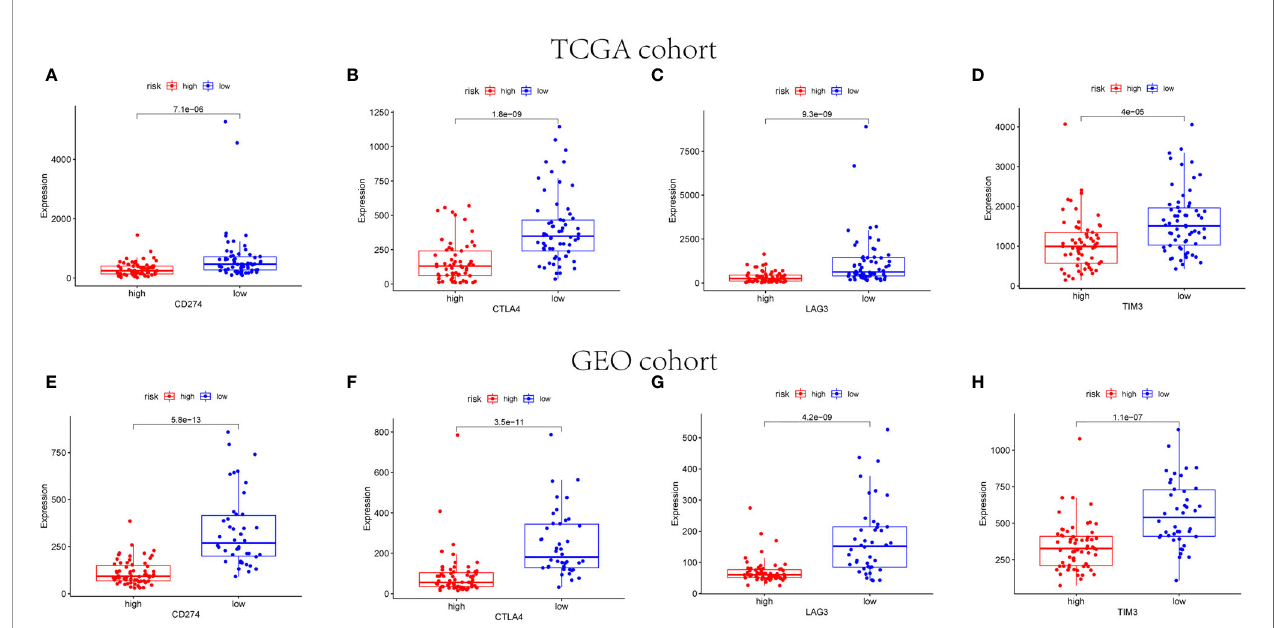
FIGURE 12 | Immune checkpoint gene expression levels in high- and low-risk groups. The expression levels of CD274 (A) , CTLA4 (B) , LAG3 (C) , and TIM3 (D) in each group in TCGA cohort ( p < 0.001). The expression levels of CD274 (E) , CTLA4 (F) , LAG3 (G) , and TIM3 (H) in each group in GEO cohort ( p <